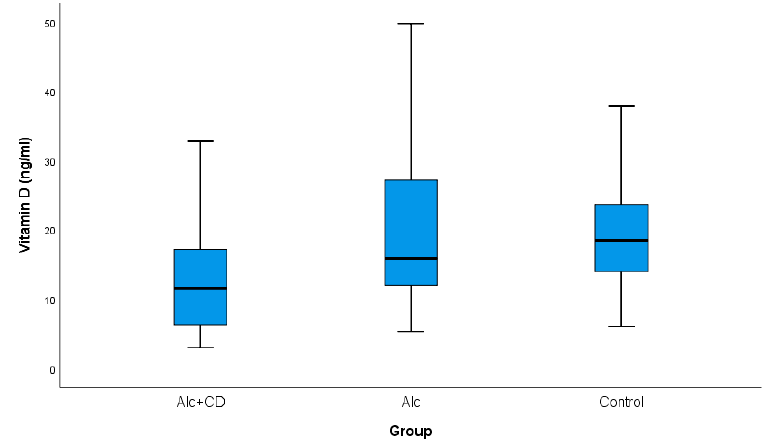
Figure 1. Vitamin D levels by groups. Notes: Alc + CD—alcohol-dependent individuals with cognitive deficiency; Alc—alcohol-dependent individuals without cognitive deficiency; Controls. The mean MoCa score was 23.5 ± 1.5 in the Alc+CD group, 27.2 ± 1.3 in the Alc, and 27.9 ± 1.1 in controls, respectively. There was statistical difference (F (2129) = 133.688; p < 0.0001).